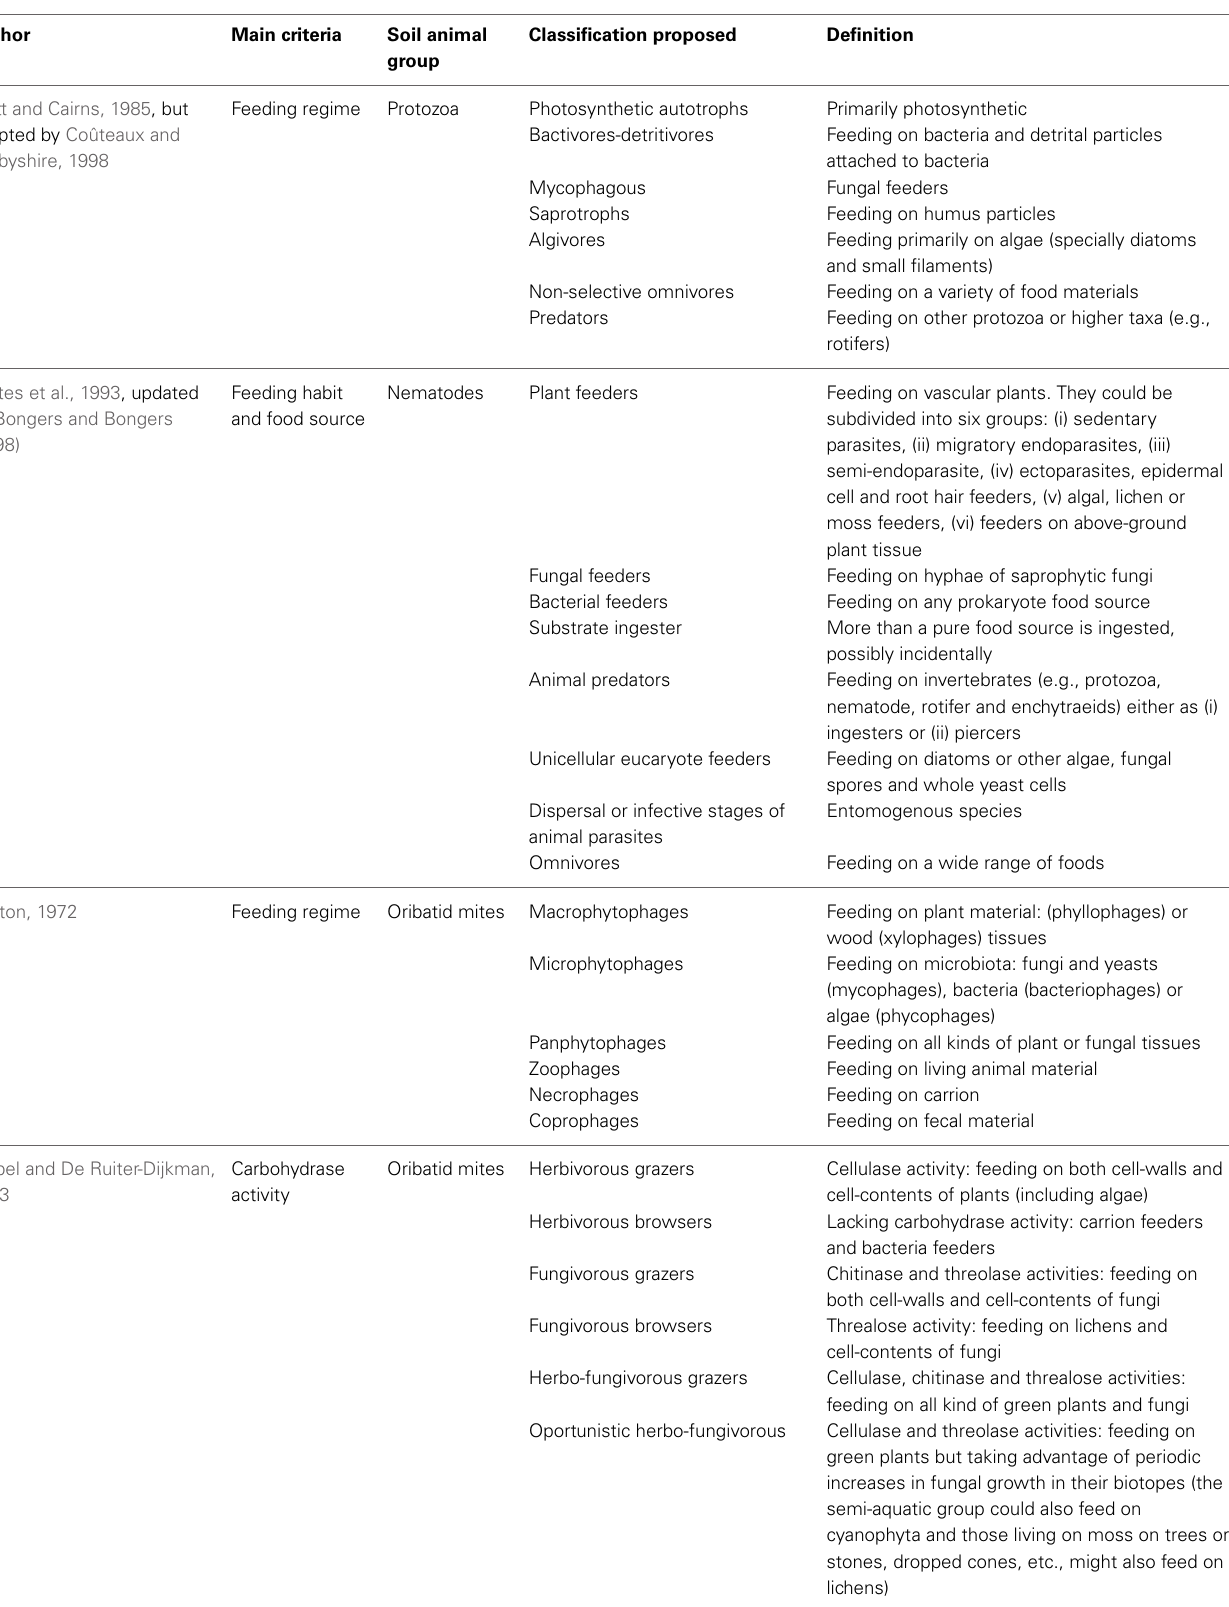
Table 1 | Functional classifications of different soil invertebrates based on different criteria and including the definition of the proposed